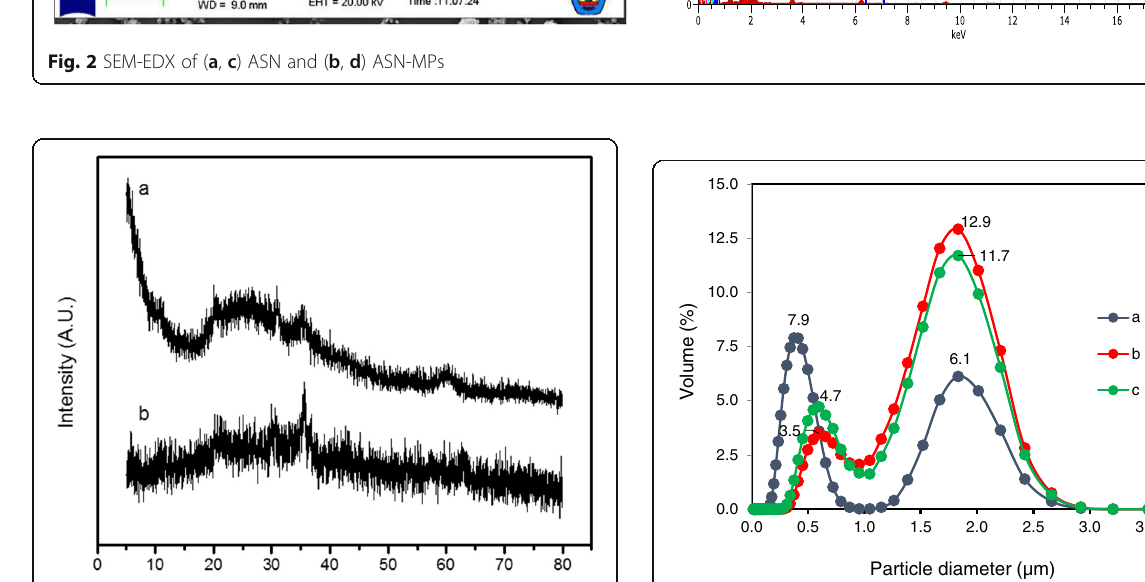
Fig. 4 Particle size distribution of ( a ) Fe 3 O 4 , ( b ) ASN, and ( c )